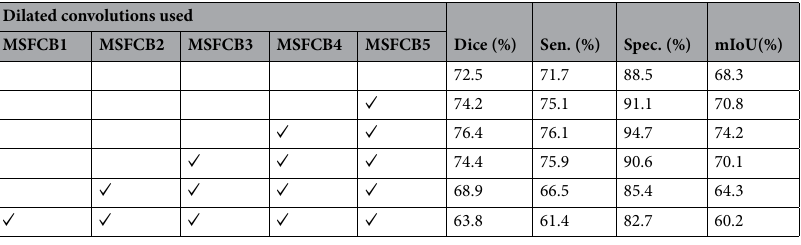
Table 2. Comparison of networks using a different number of dilated convolutions.